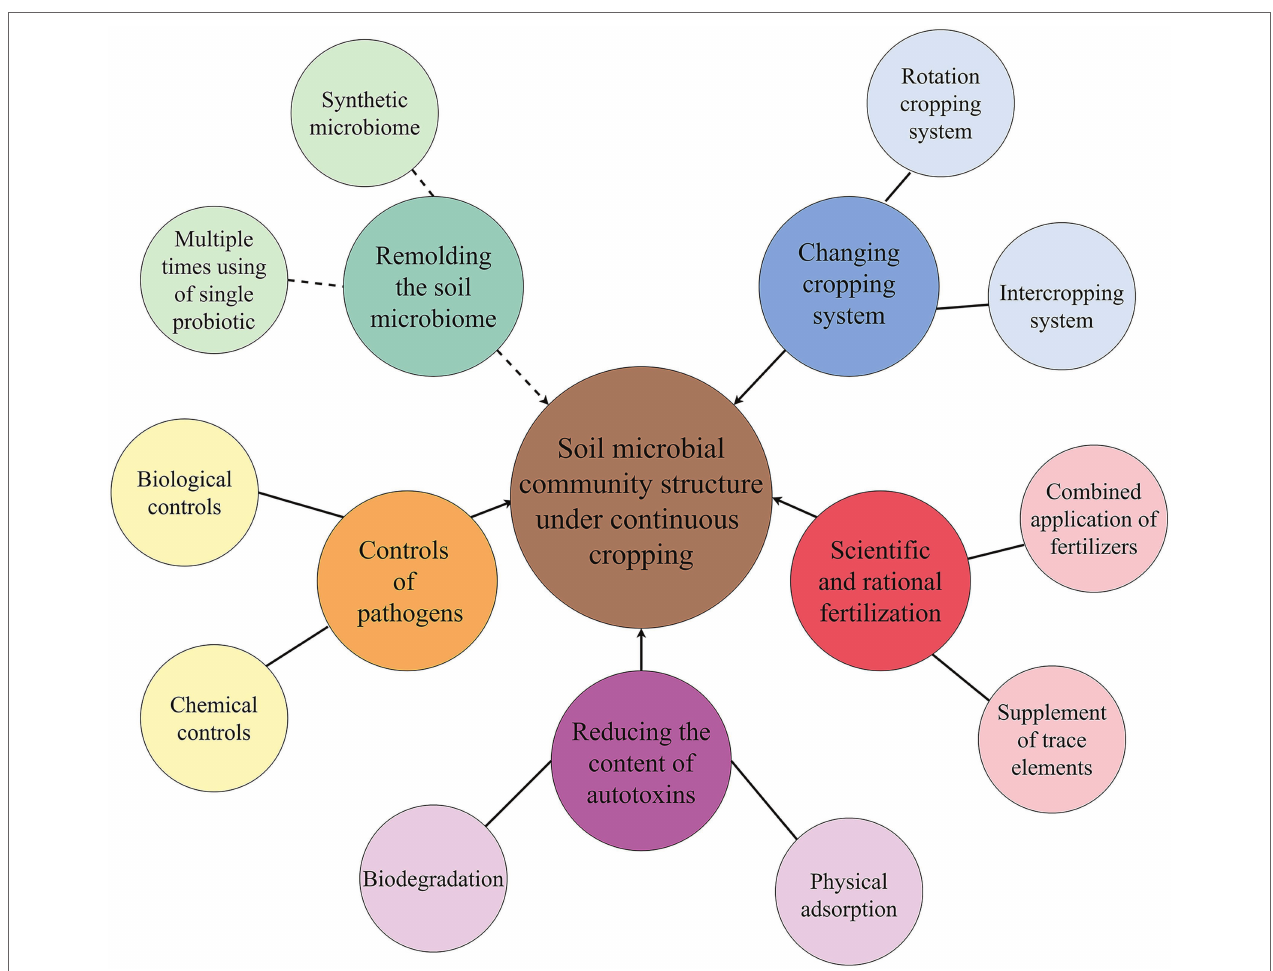
FIGURE 3 | Improvement measures of soil microbial community structure under continuous cropping. The solid line indicates the measures currently used in agricultural production, and the dotted line indicates the measure that will be involved in the mitigation of continuous cropping obstacles in the